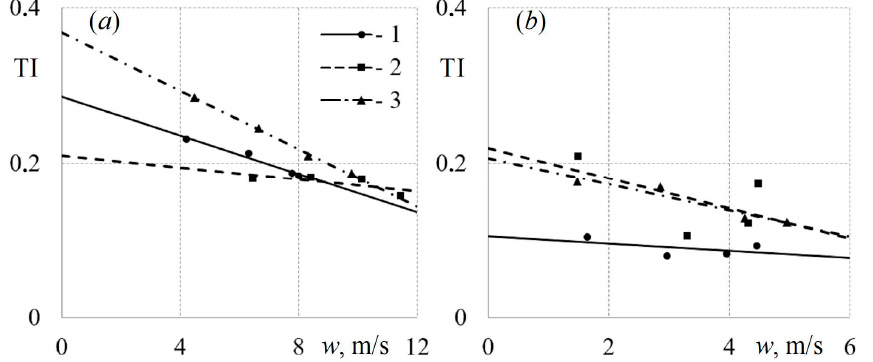
Figure 10. Dependences of the turbulence intensity TI on the average air flow velocity w when air is supplied through round (1), square (2), and triangular (3) tubes for various control sections: ( a )—control section at the height of H 1 = 100 mm; ( b )— H 4 = 800 mm. The mathematical description of the function TI = f ( w ) for the first section ( H 1 = 100 mm) when air is supplied through round (5), square (6), and triangular (7) tubes has the following form (approximation reliability not less than